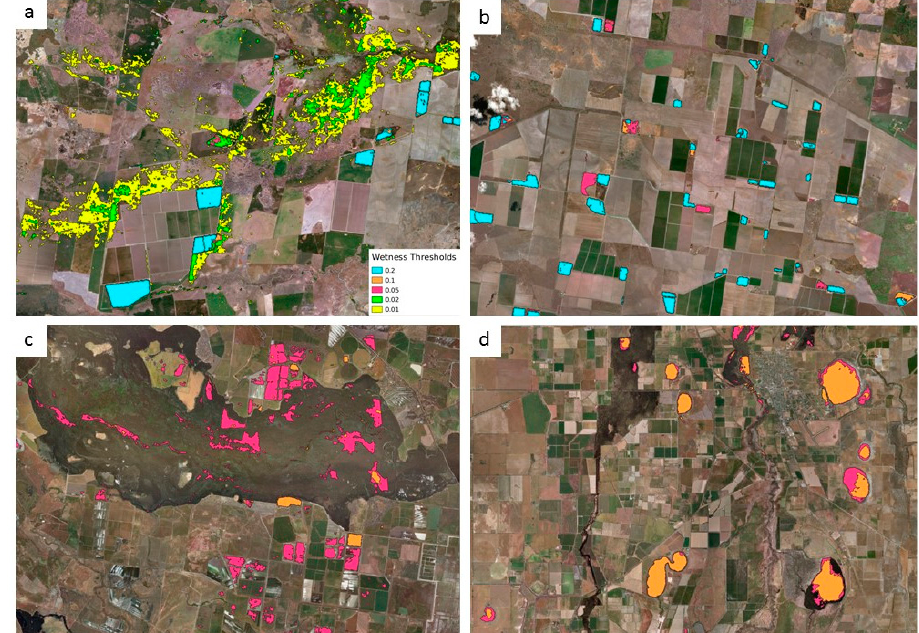
Figure A2. Waterbody polygons identified using the different wet frequency thresholds. The color of the polygon indicates the highest threshold that an area is identified by, e.g., if you see an area in pink, this has been detected by the 0.05, 0.02 and 0.01 thresholds; if it’s blue, then it has been detected by all thresholds etc. ( a ) All wet frequency threshold polygons. ( b ) 0.01 (yellow) and 0.02 (green) thresholds removed. Locations missed by the 0.2 (blue) threshold are shown in pink/orange. ( c ) Just 0.05 (pink) and 0.1 (orange) thresholds. Locations missed by the 0.1 (orange) threshold are shown in pink. ( d ) Just 0.05 (pink) and 0.1 (orange) thresholds. Locations missed by the 0.1 (orange) threshold are shown in pink. Legend for all figures as in ( a ). Both the 0.05 and 0.1 thresholds showed both errors of omission and commission, depending on the location in which they were applied. In a location with large areas of